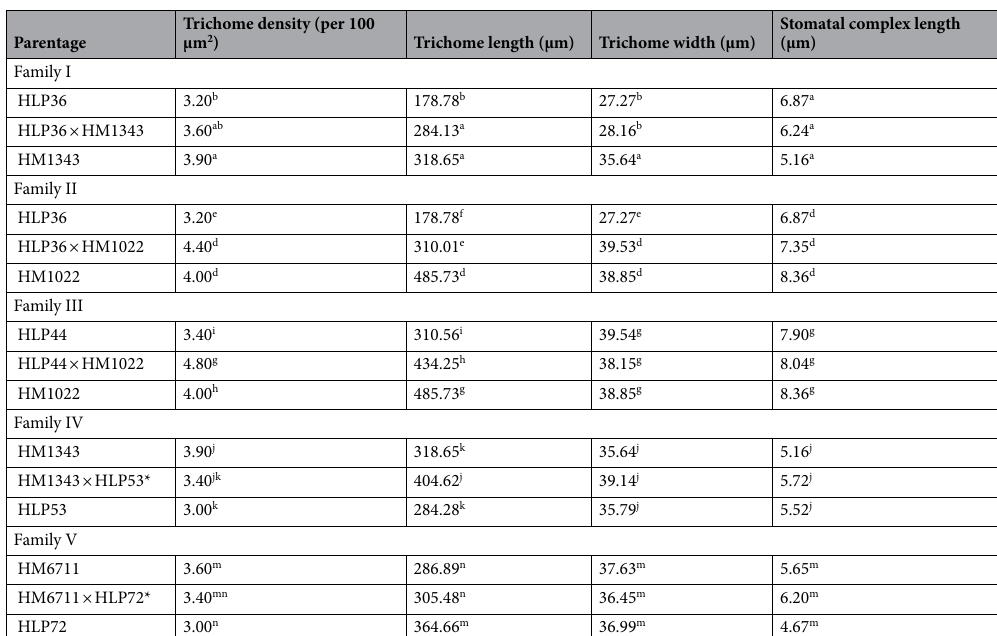
Table 5. Micromorphological characterization of interspecific hybrids and their parents. *Derived through ovule culture. Mean values with different letters in a respective family number’s column are significantly different at P ≤ 0.05 according to Tukey’s HSD (Honest Significant Difference) test. Family numbers are designated with different letters as: Family I: a–c, Family II: d–f, Family III: g–i, Family IV: j–l, Family V: